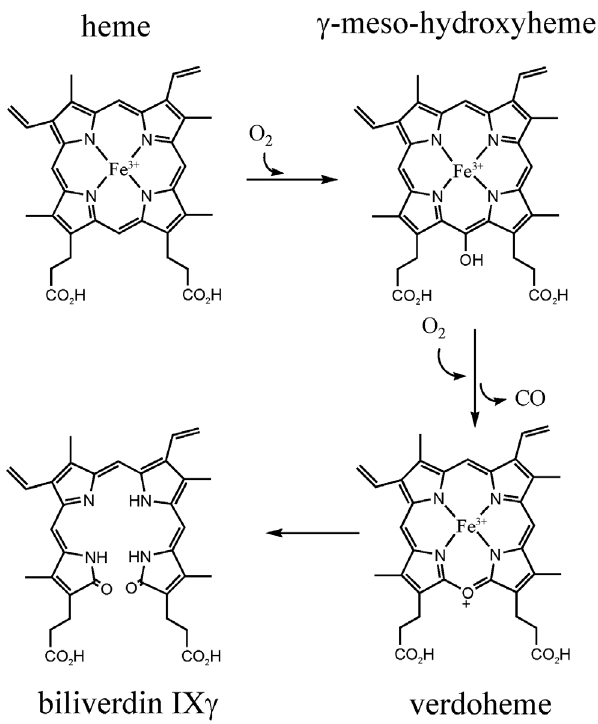
Figure 1. Proposed reaction pathway for the formation of biliverdin IX c from heme by a heme oxygenase-like mecha- nism.